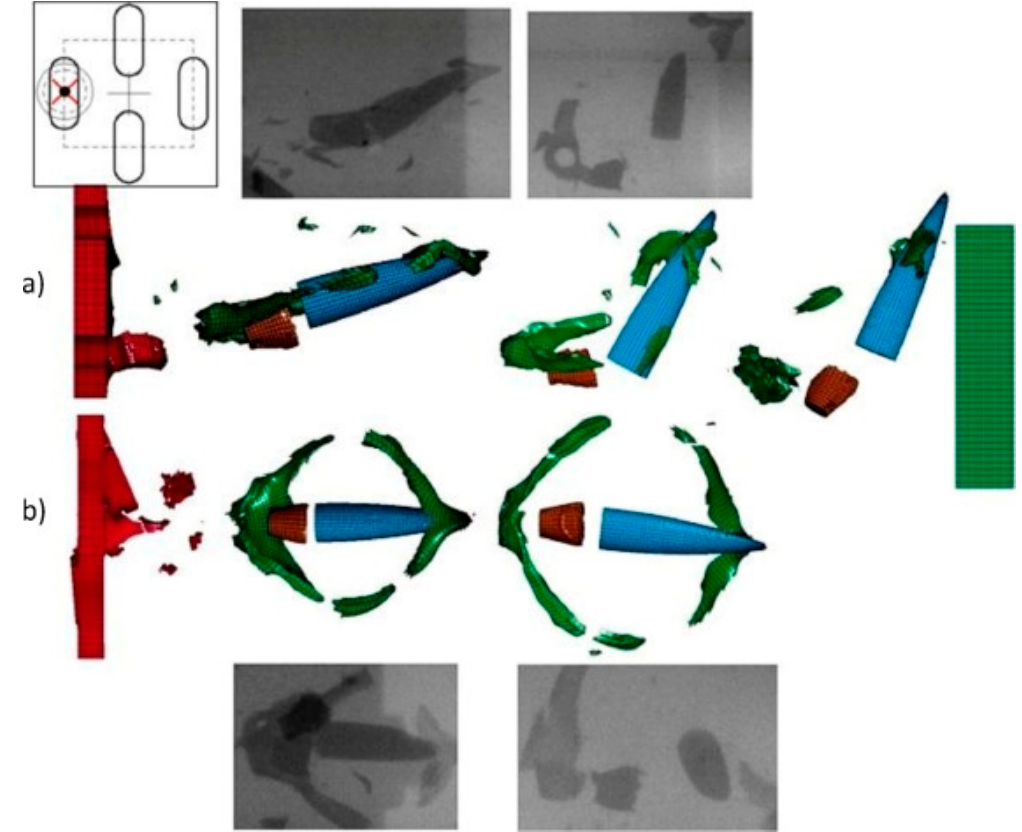
Figure 9. Numerical results of the AP impact in the center of the perforation compared with the flash X-ray images: ( a ) bottom view; ( b ) side view [43]. Reprinted with permission from Elsevier: Int. J. Impact Eng. , Copyright 2021, License: 5017590451474.